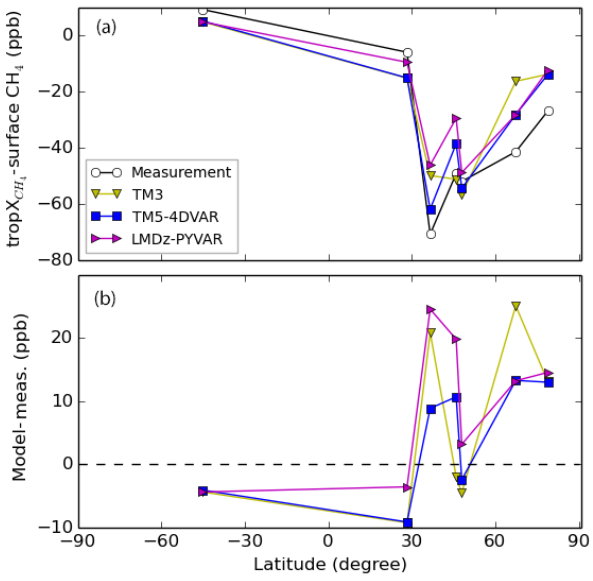
Figure 4. Measured (black) and simulated (yellow: TM3, blue: TM5-4DVAR, magenta: LMDz-PYVAR) vertical gradients of CH 4 in the troposphere (a) and differences between the measurement and simulations (b) against latitude. The results are averaged for 2007– 2011 when FTS measurements are available.